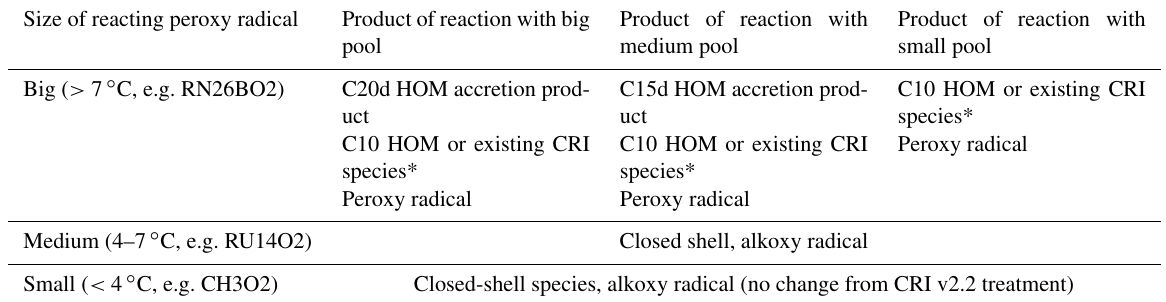
Table 2. Summary of possible products formed for a particular peroxy radical reacting with the big, medium and small peroxy radical